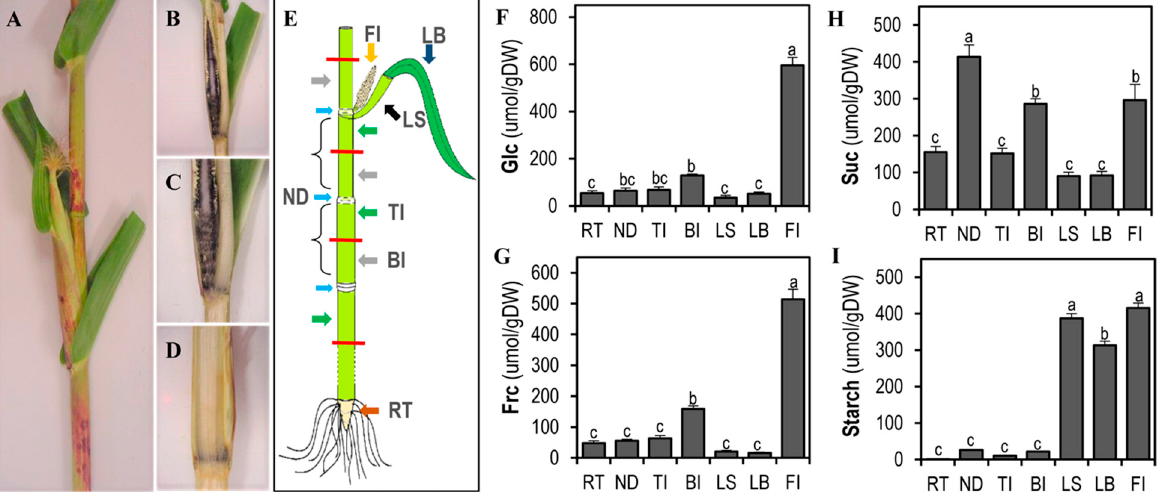
Figure 2. Starch staining and non-structural carbohydrate levels in Puma maize hybrids at 60 DAS (R1 stage). ( A ) Maize stem at 60 DAS showing female inflorescence with emerging stigmas. ( B – D ) Longitudinal cuts of the stem and the female inflorescence stained with iodine (KI-I 2 ) showing starch accumulation. ( E ) Diagram of different tissues sections collected. ( F – I ) Carbohydrate quantification of Puma hybrid tissues at 60 DAS. Plants were divided into different tissue sections: root, RT; stem node, ND; top internode, TI; bottom internode, BI; leaf sheath, LS; leaf blade, LB; and female inflorescence, FI. ( F ) glucose, Glc; ( G ), fructose, Frc; ( H ) sucrose, Suc; and ( I ) starch levels in the different tissues. Bars are the average of n = 10, SE; ANOVA, Fisher-LSD test p = 0.05; means with the same letter (a, b or c) are not significantly different.